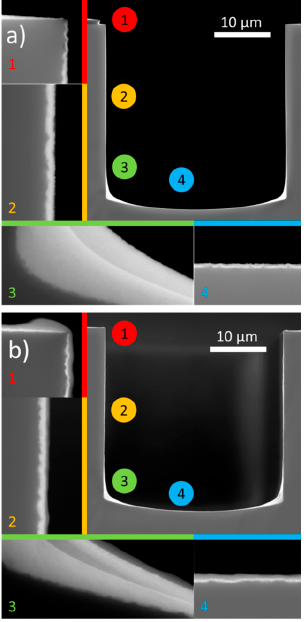
Figure 6. ( a ) SEM micrograph of 10 cycles of W-precursor deposition on a trench of 30 by 30 µ m, annealed at 500 ◦ C for 10 min in static air; and ( b ) additional deposition of 10 layers of Li-La-Ti-precursor deposition at 200 ◦ C with an anneal at 500 ◦ C for 10 min. Numbers indicate enlarged image